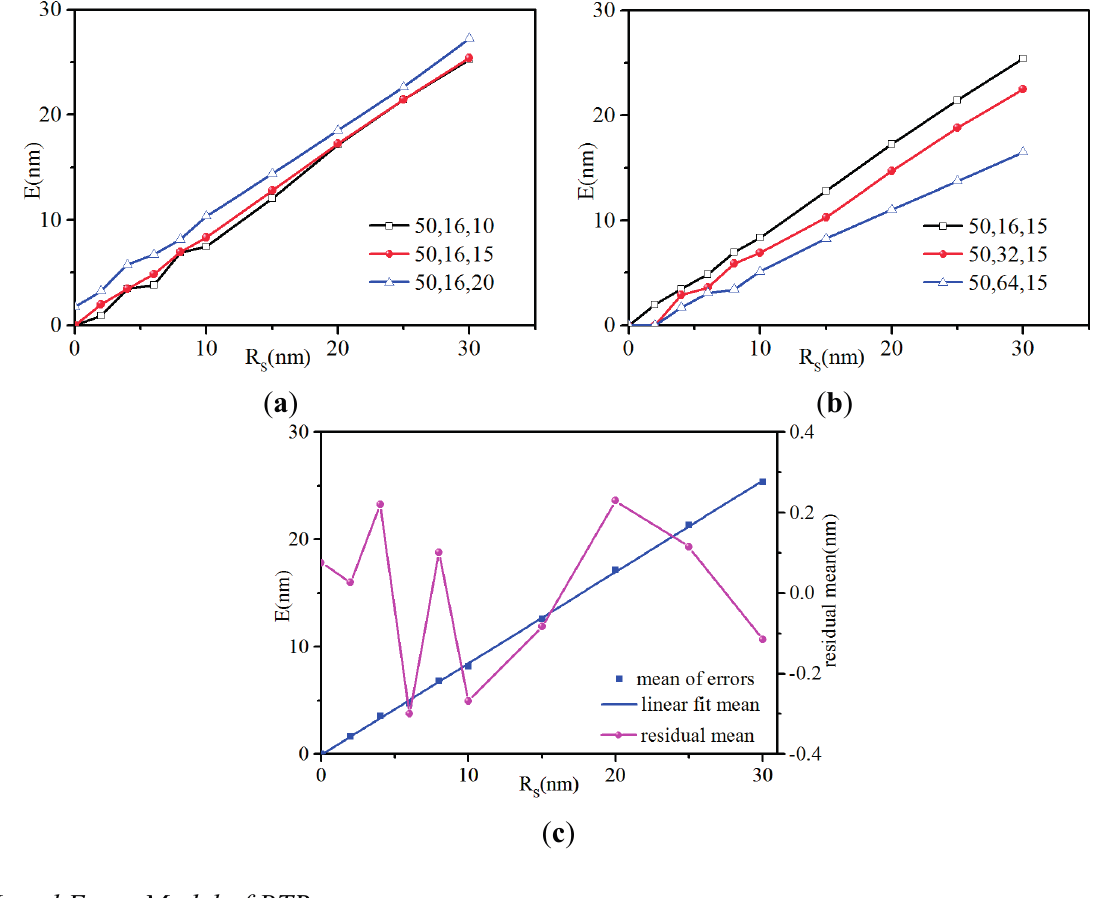
Figure 4 . The errors between the reconstructed tip and the actual tip obtained by various samples and tips. ( a ) The comparison of the errors ( E on the Y axis) between (50, 16, 20), (50, 16, 15) and (50, 16, 10); ( b ) The comparison of the errors between (50, 16, 15), (50, 32, 15) and (50, 64, 15); ( c ) The mean of the errors between (80, 16, 15), (50, 16, 15) and (20, 16, 15) and associated linear fit. The residual mean is the deviation between the mean values calculated for each R s and their fitted